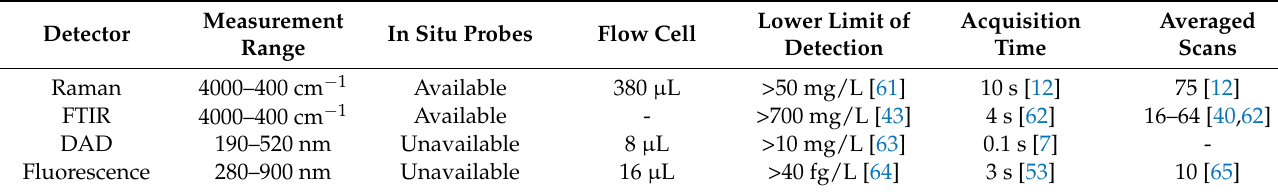
Table 1. Overview of measurement parameters for Raman, Fourier-transformed infrared (FTIR) diode-array detector (DAD) and fluorescence from literature and manufacturers.